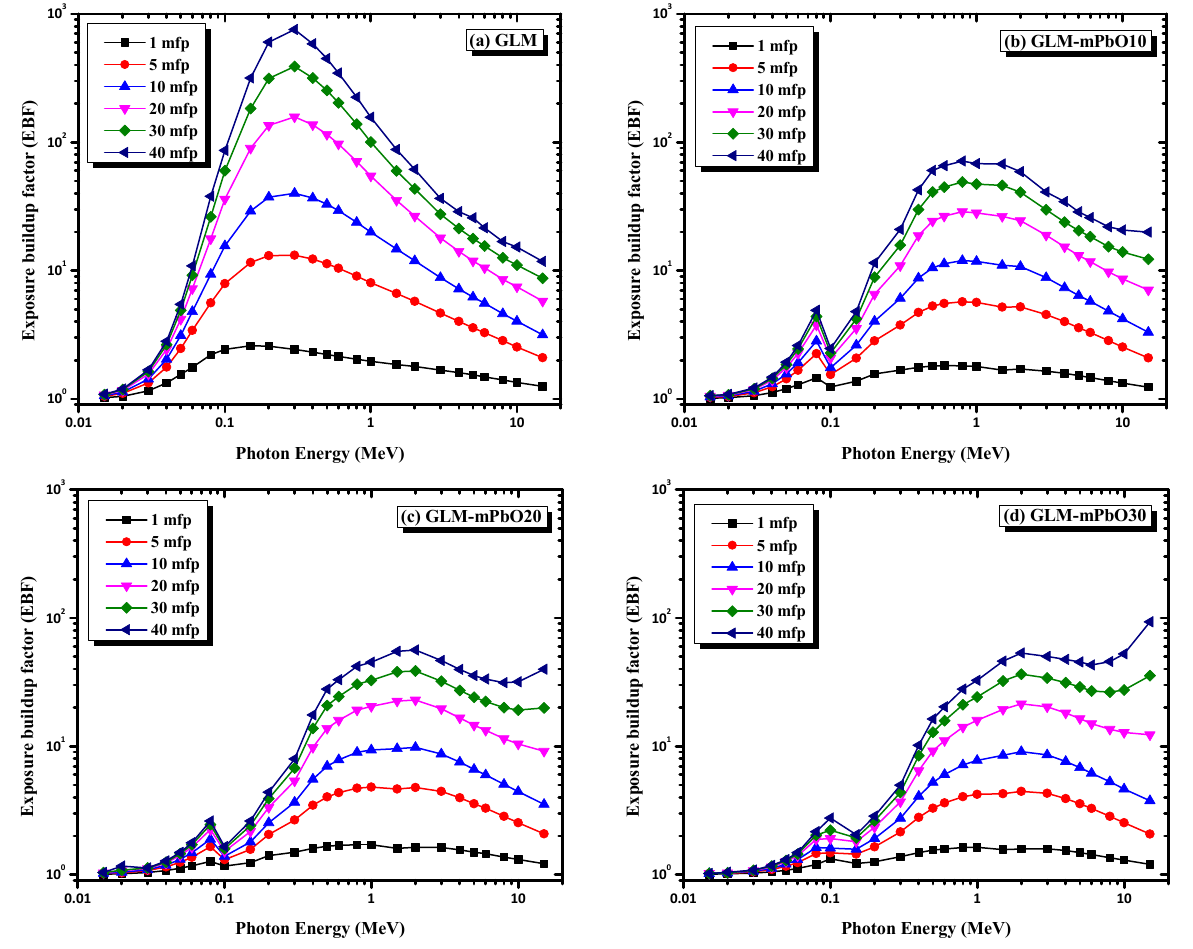
Figure 12. The energy buildup factor EBF dependence on energy at 1 mfp, 5 mfp, 10 mfp, 20 mfp, 30 mfp, and 40 mfp for mortars.